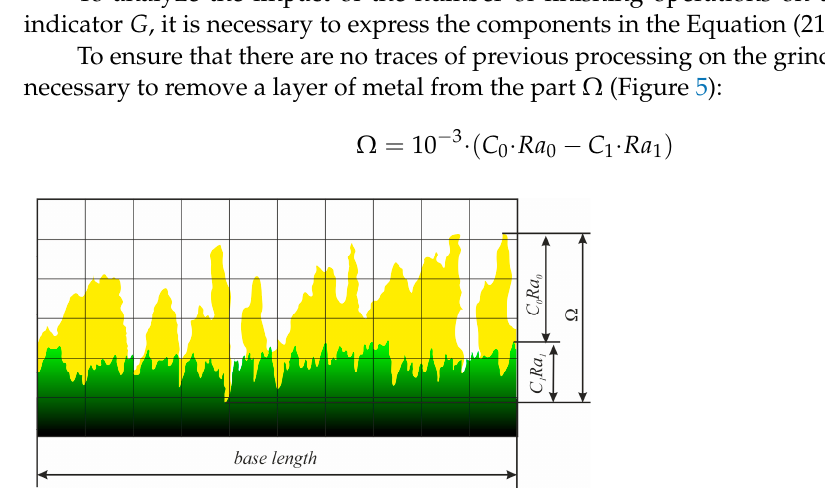
(Figure 6). In the calculations in accordance